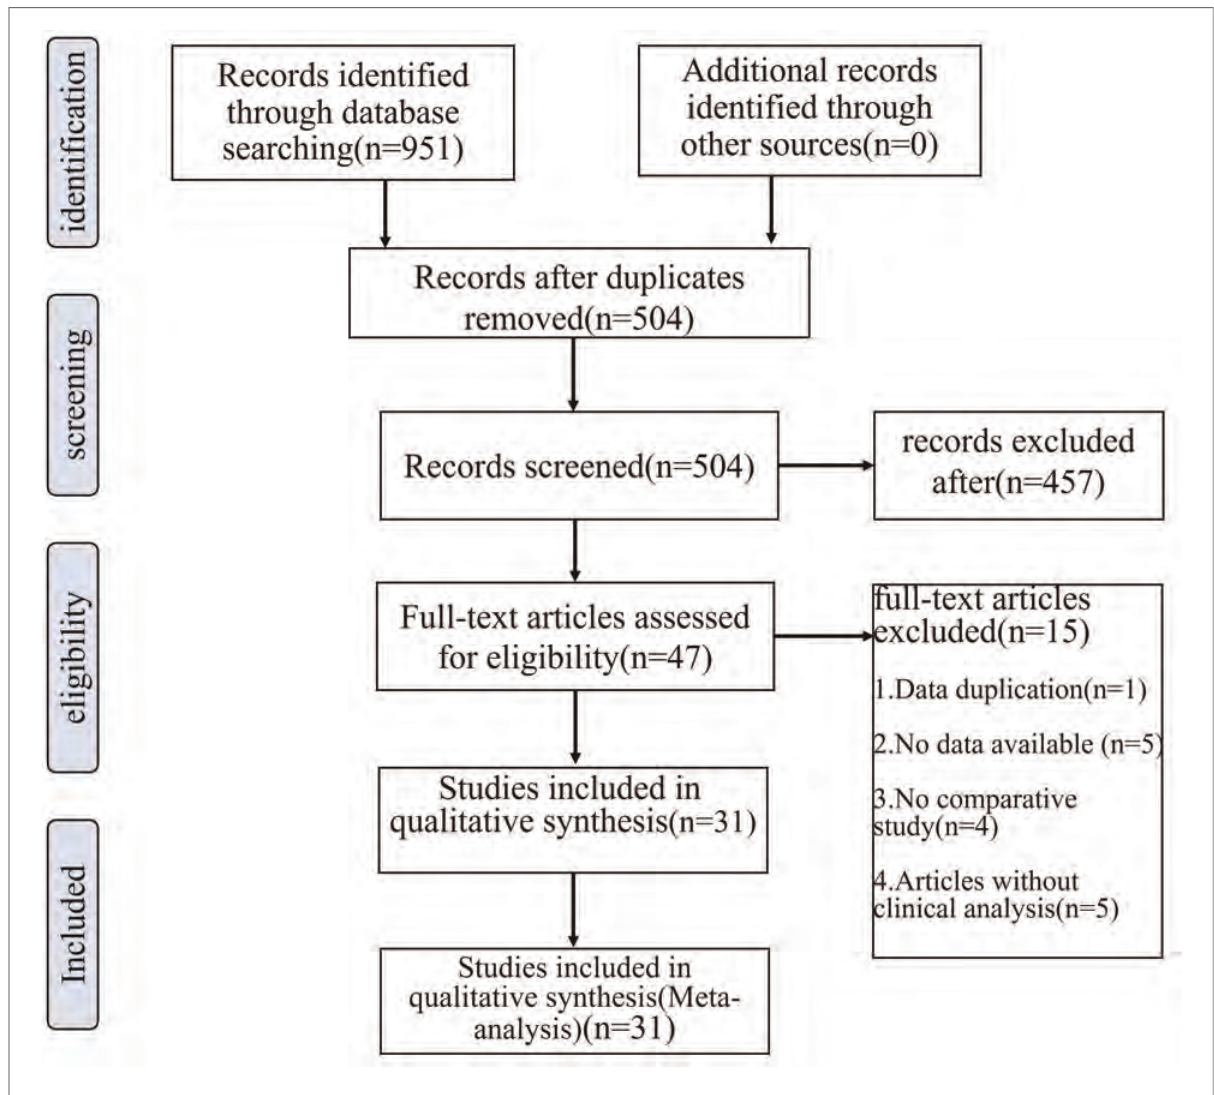
FIGURE 1 Literature screening fl ow chart in